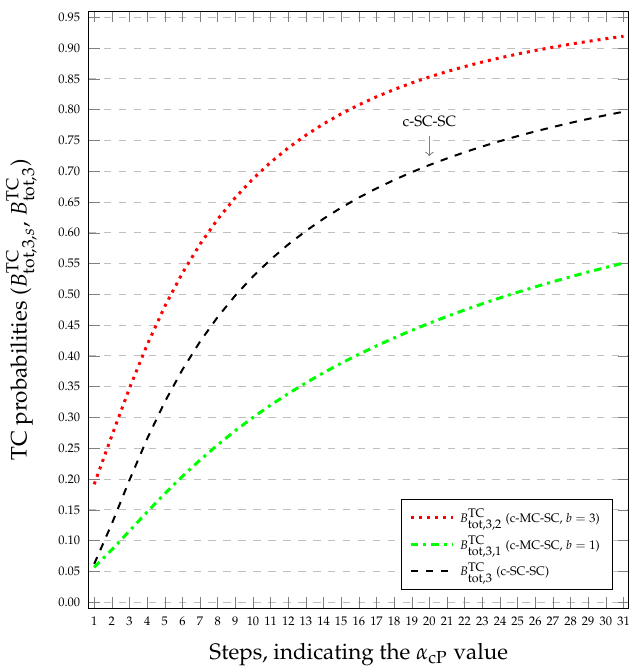
Figure 8. Total TC probabilities, B TC vs. c-SC-SC).